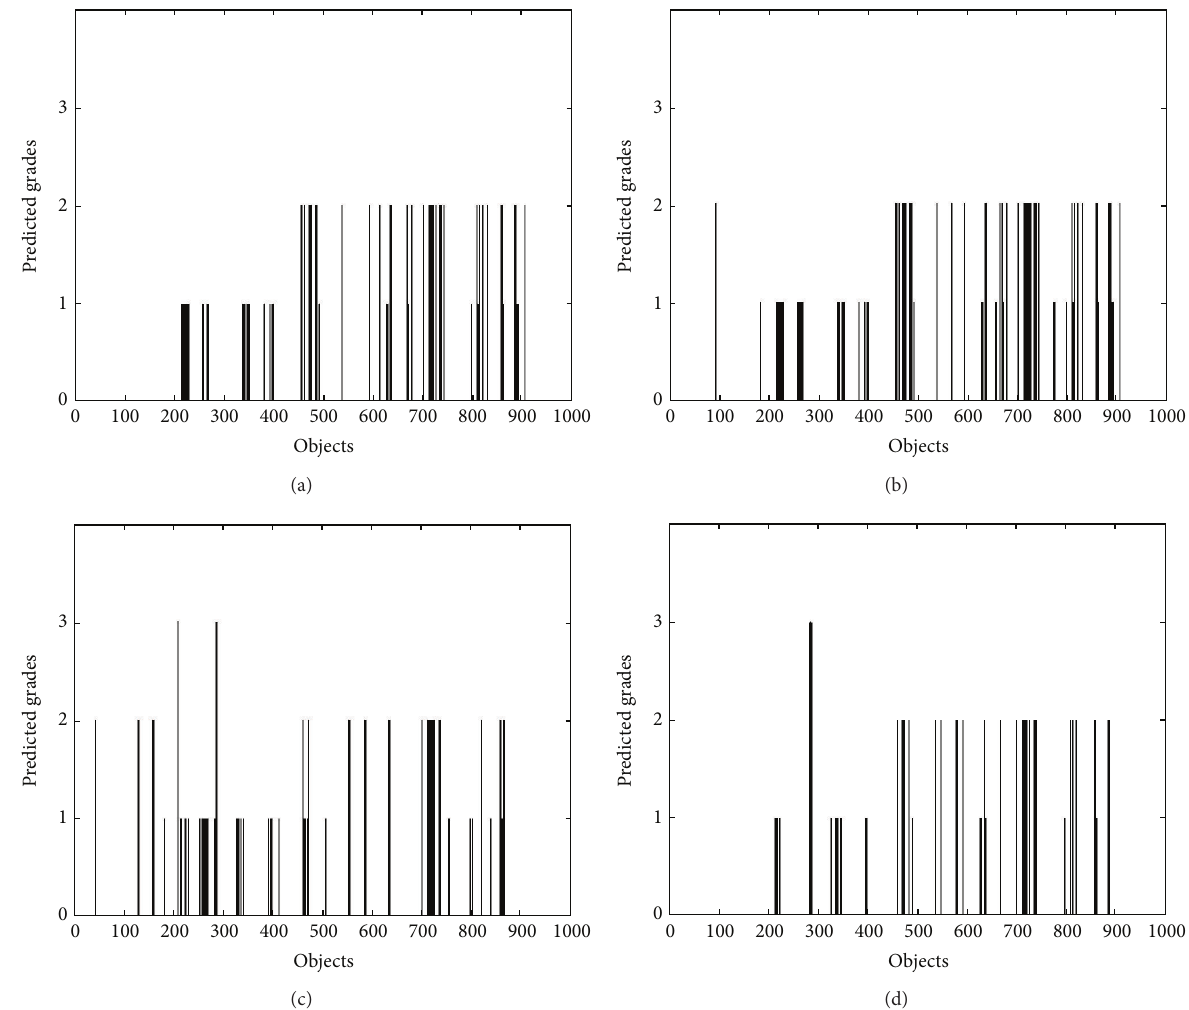
Figure 4: PLSDA classification of Longjing grades for the test objects (objects 1–161, grade I; objects 162–452, grade II; objects 463–912, grade III) with raw (a), smoothed (b), second-order derivative (c), and SNV (d) spectra. The correctly classified objects are not displayed. The location of a bar indicates a misclassified object, and the height indicates to which grade it was wrongly assigned.